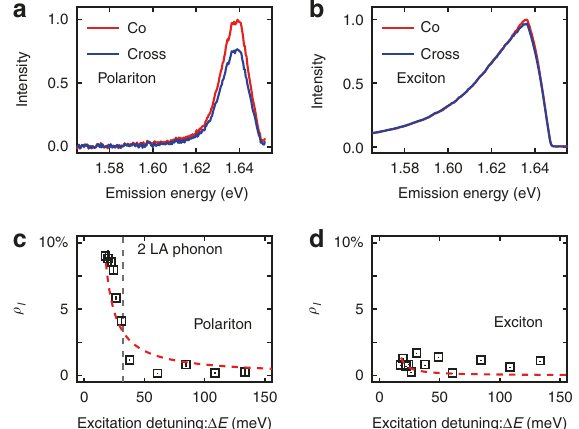
Fig. 3 Valley coherence of polariton vs. bare exciton. a , b PL spectrum of lower polariton ( a ) and bare exciton ( b ) under 745 nm linearly polarized pump. Detection and excitation are cross- and co-linearly polarized with each other. c , d Lower polariton ( c ) and bare exciton ( d ) valley coherence ρ l as a function of excitation detuning Δ E . Red dashed line is fi tted to the same model with MSS dephasing mechanism, gray dashed line is an indication of 2 longitudinal acoustic (LA) phonon energy. Errorbars represent the standard deviation among